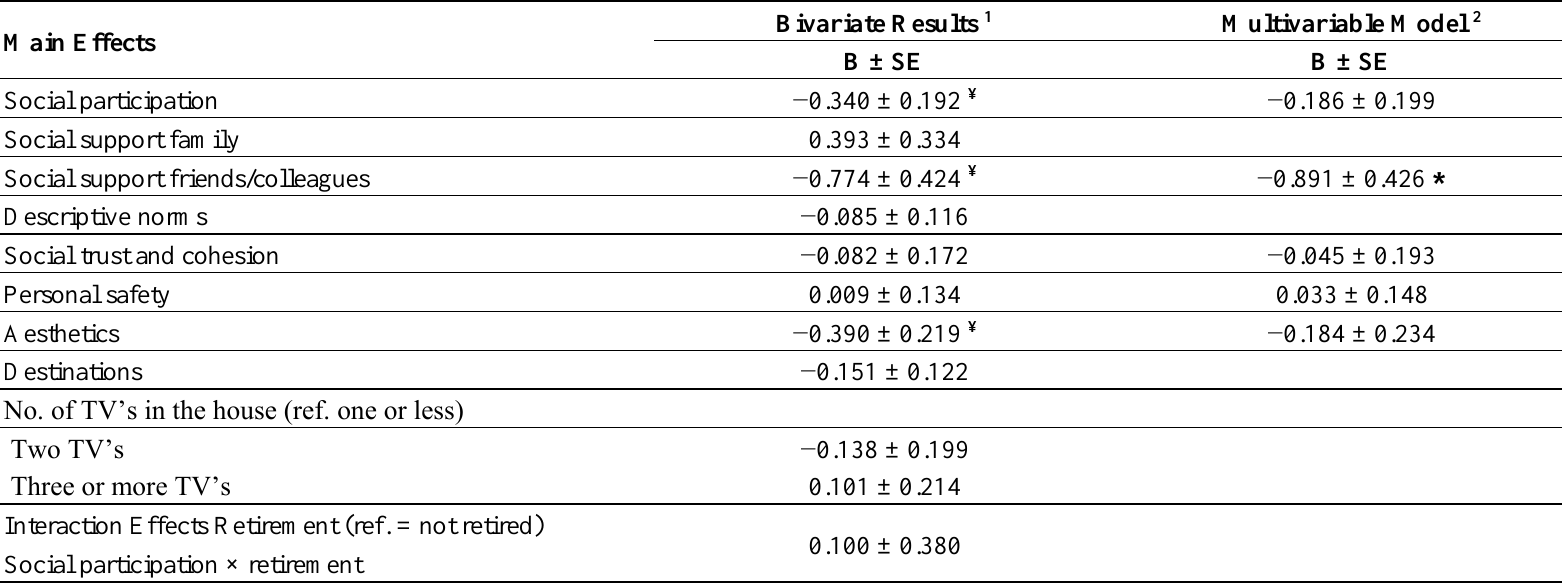
Table 2. Bivariate and multivariate results for social and environmental correlates of weekend day